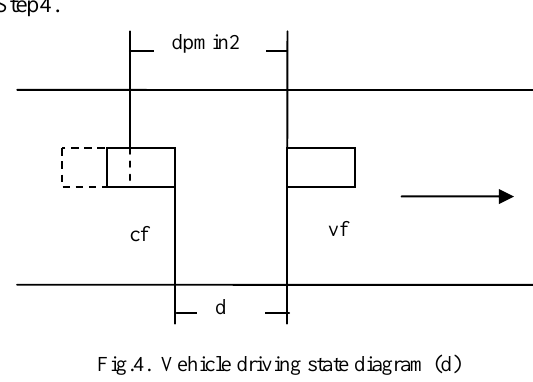
Fig.4. Vehicle driving state diagram (d)